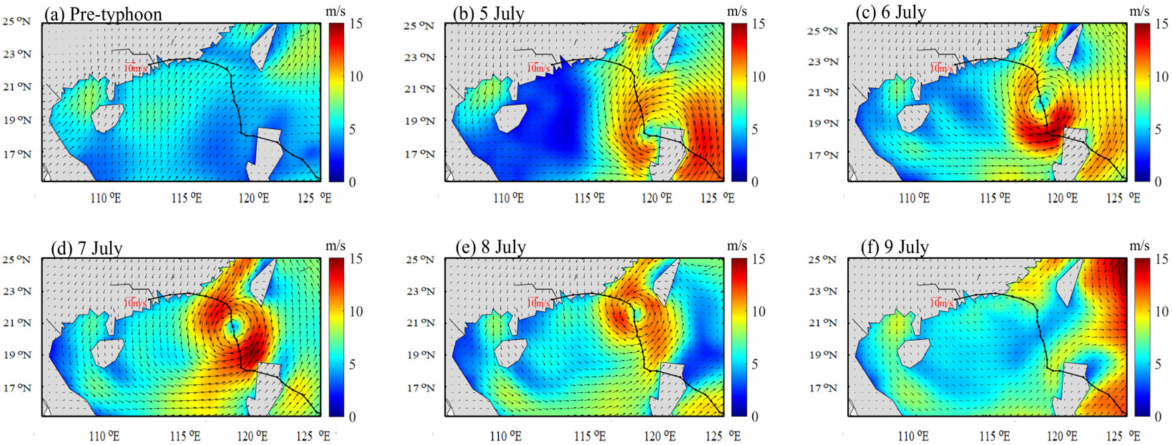
Figure 8. Spatial distribution of 10 m wind vector (arrows) and wind speed (shading) during pre-typhoon ( a ) 1–4 July and on 5 July ( b ), 6 July ( c ), 7 July ( d ), 8 July ( e ), 9 July ( f ). The black line denotes typhoon path.